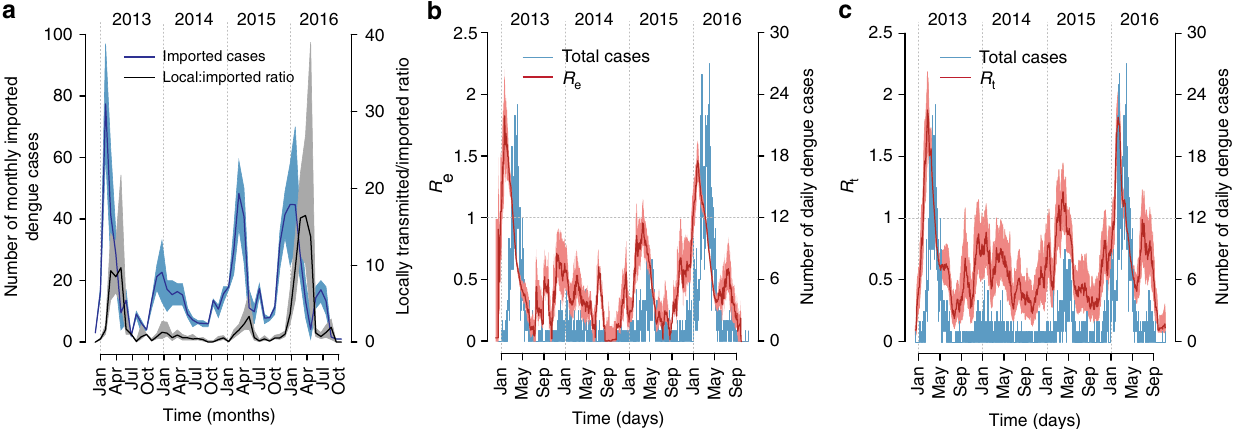
Fig. 2 Epidemic course and reproduction numbers. a Estimated mean number (and 95% CI) of imported cases over time (blue line and shaded area, scale on the left) and mean ratio (and 95% CI) of the number of locally transmitted cases to the number of imported cases over time (black line and shaded area, scale on the right). b Effective reproduction number R e (mean and 95% CI) over time, compared with daily cases. c Instantaneous reproduction number R t (mean and 95% CI), computed from the renewal